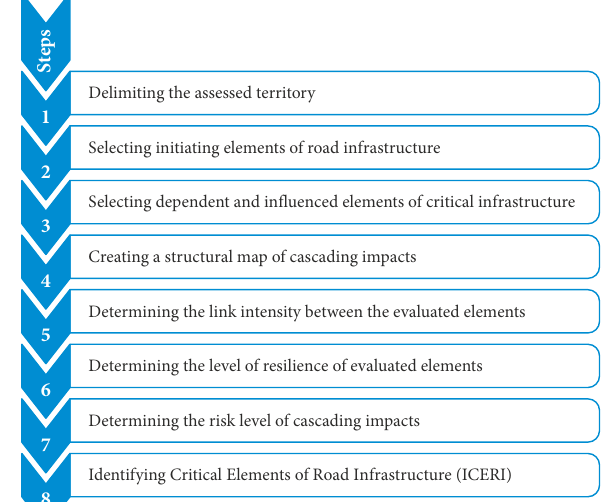
Figure 3. Procedure for applying the ICERI method